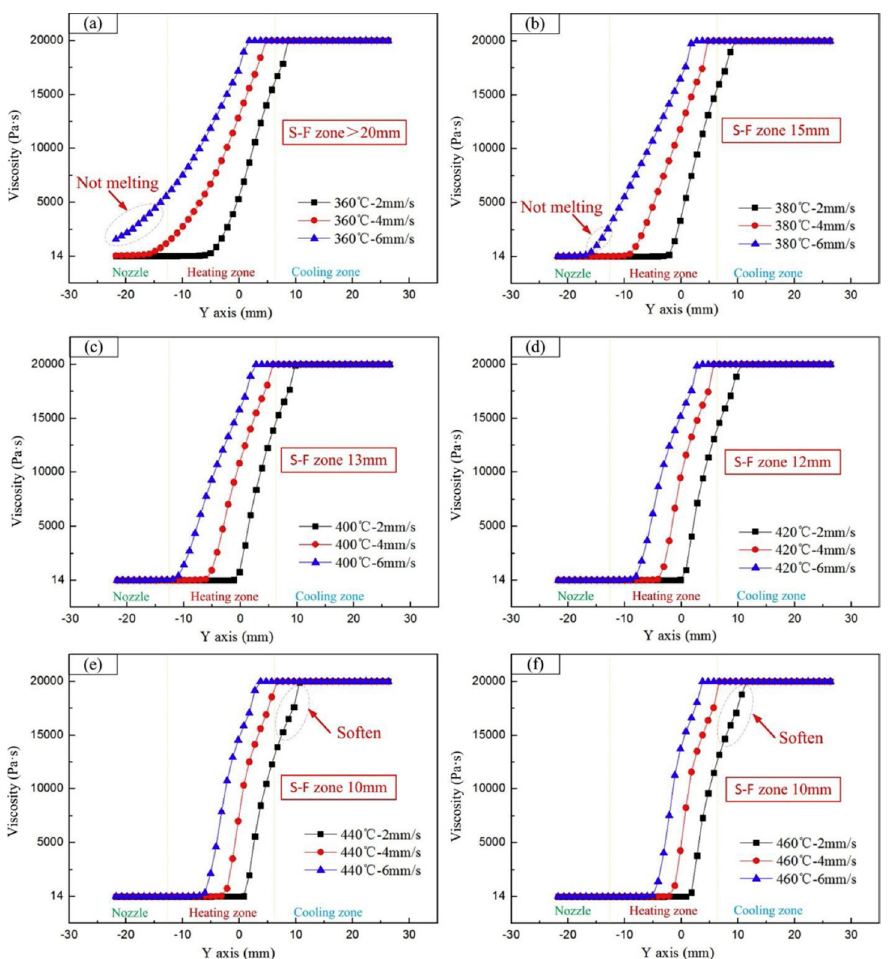
Figure 13. Viscosity of PEEK at various heating temperatures and wire feeding speeds (2, 4 and 6 mm/s) ( a ) at 320 ° C ( b ) at 380 ° C ( c ) at 400 ° C ( d ) at 420 ° C ( e ) at 440 ° C and ( f ) at 460 ° C [84].